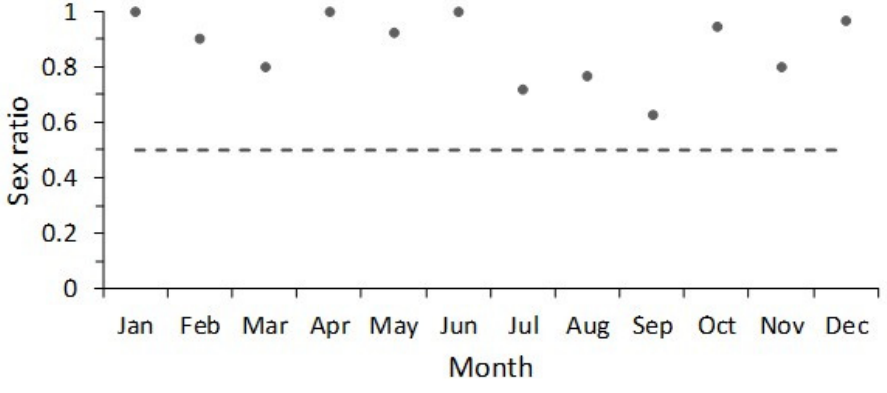
Figure 2. Monthly sex ratio (F:M) of giant electric rays, Narcine entemedor. Table 2. Monthly values of chi-squared (X 2 ) test estimated for Narcine entemedor from the Bahía de La Paz, Baja California Sur, Mexico.